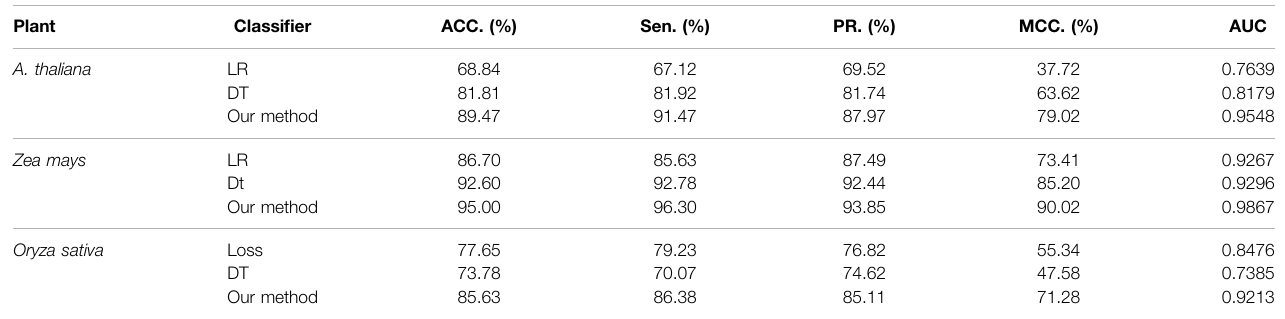
the AC149810.2_FGP003 protein. After yielding the predicted results, we veri fi ed the top 20 PPI pairs with the highest predicted scores in the newly published literature. As shown in Table 6 , 14 of the top 20 predicted proteins are veri fi ed in the experimental